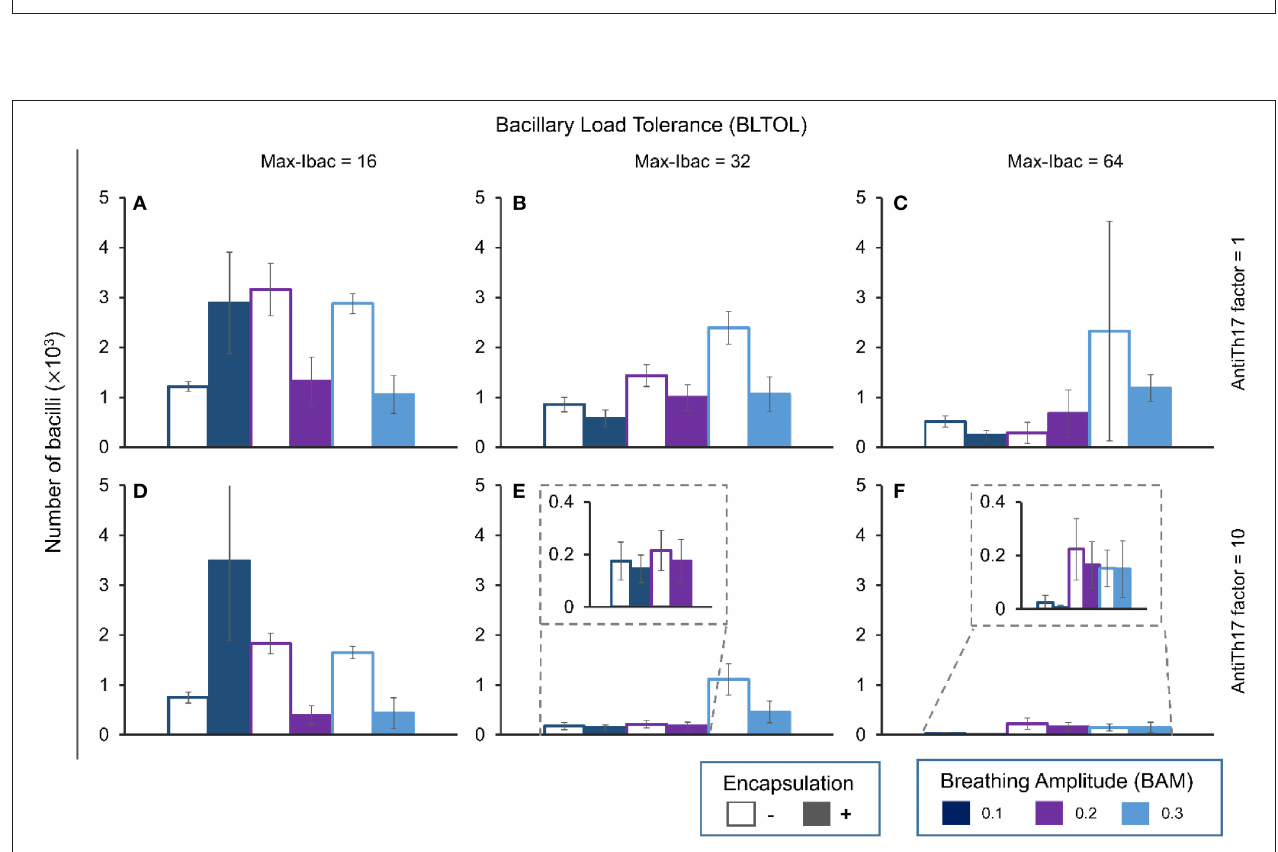
FIGURE 3 | Influence of maximum bacillary load per macrophage (Max-Ibac = 16, 32, 64) (BLTOL), encapsulation factor ( − , no encapsulation, + , encapsulation) and breathing amplitude (BAM) (0.1, 0.2, 0.3) on the time to reach a total bacillary population of 10 4 cells. Results for AntiTh17 factor are not shown separately because no significant differences were found. Bars indicate the mean of 20 runs. * Only 50% of runs reached the bacillary population of 10 4 cells before day 42.